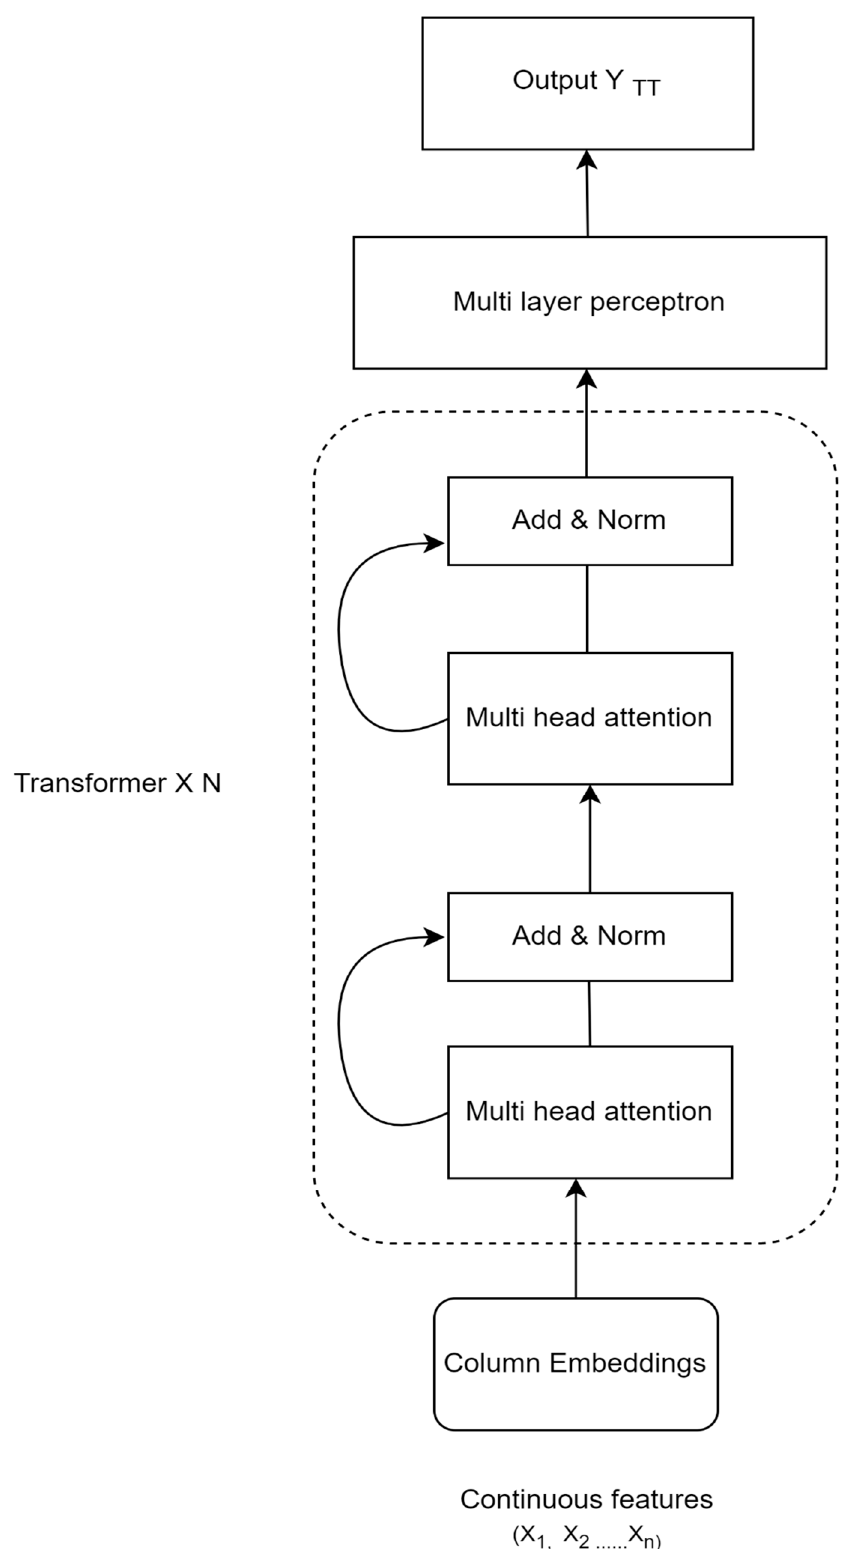
Figure 3. Proposed tab transformer architecture.